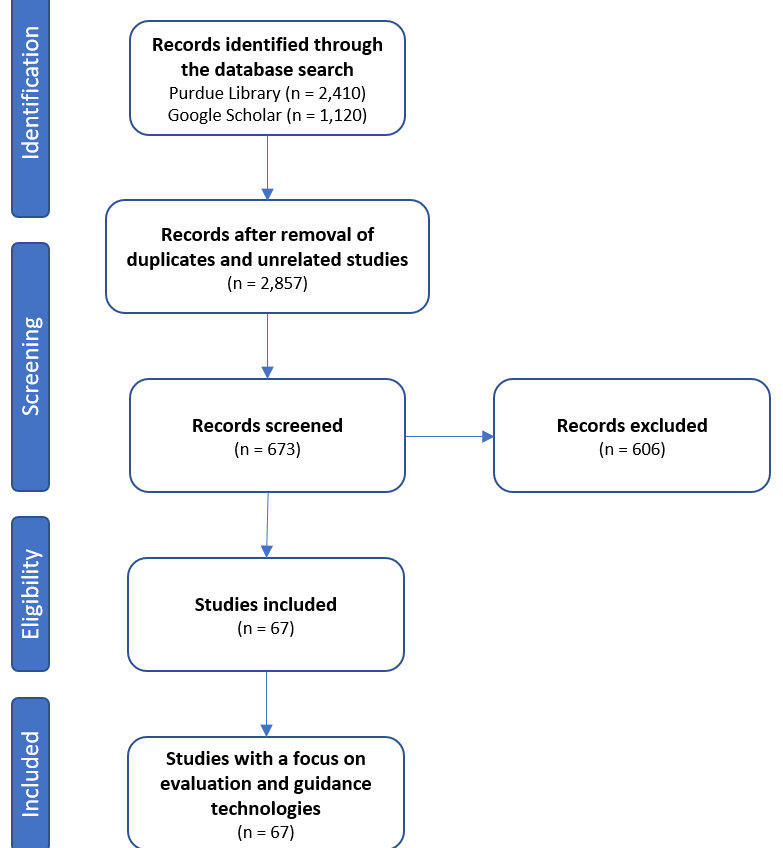
Figure 2. Flowchart of the study selection